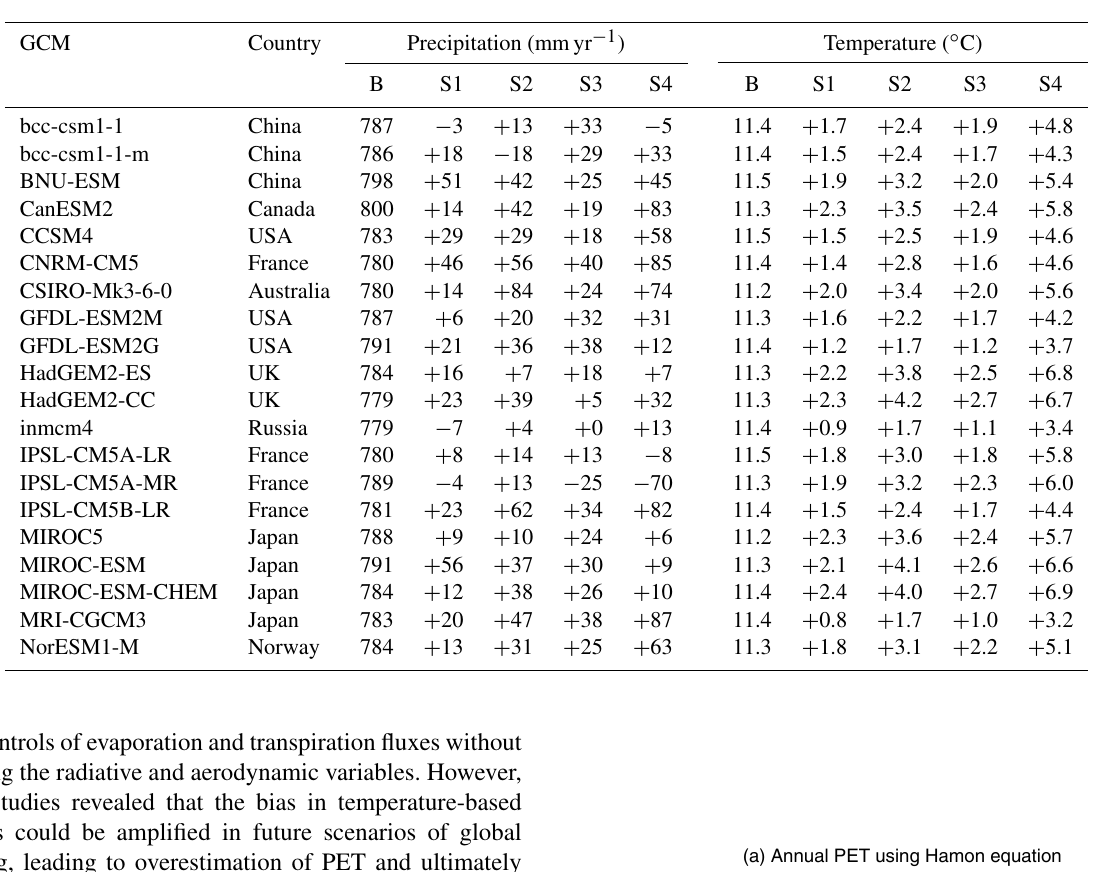
Table 1. List of the 20 climate models and the changes in mean annual precipitation and temperature over the conterminous United States (CONUS) from the baseline scenario (B) to future scenarios S1 (RCP4.5/2030s), S2 (RCP4.5/2080s), S3 (RCP8.5/2030s), and S4 (RCP8.5/2080s).